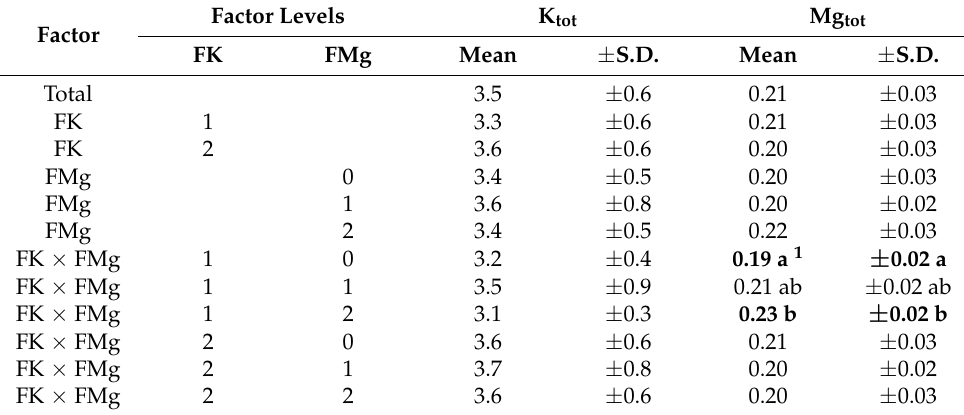
Table 7. Total removal of K and Mg (g/plant) by potato phytomass (aboveground phytomass + tubers) at the harvest in 2020 in the microplot field experiment with potassium (FK) and magnesium fertilization